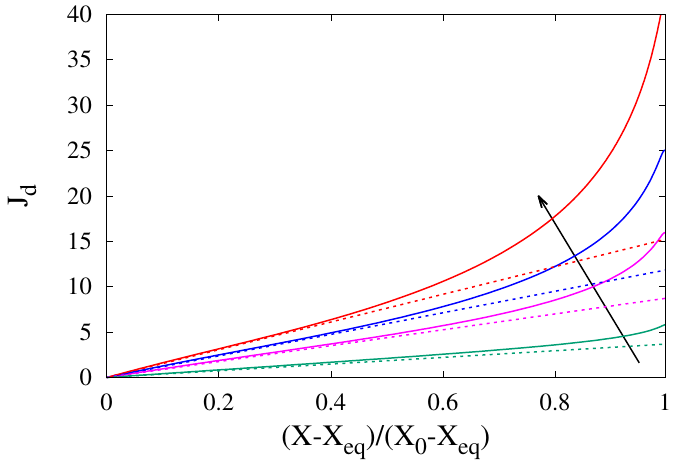
Figure 8. Dimensionless dehydration rate J d vs. moisture ratio X r = ( X − X eq ) / ( X 0 − X eq ) for Bi m = 1,3,5,9 and for a uniform initial water distribution, β core α 0 = 0.5, V eq / V 0 (cid:39) 0.85. Arrow indicates increasing values of Bi m . Dashed lines indicate the theoretical long-drying time-scales linear behaviour, Equation (23).